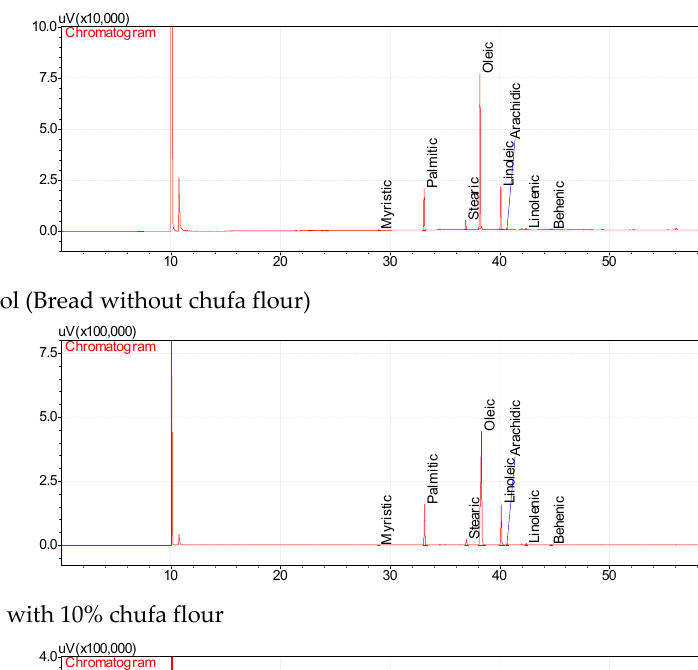
* Values are mean ± standard deviation and those with different letters in each row are significantly different ( p < 0.05); **ND: Non detected